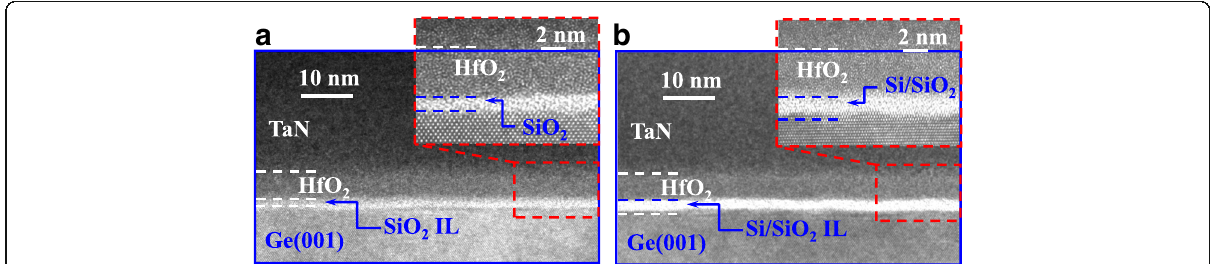
Fig. 2 Cross-sectional TEM images of Ge pMOSFET gate stacks with a 0.5 nm t Si and b 0.9 nm t Si . HRTEM images in insets show that Si/SiO 2 IL is formed between HfO